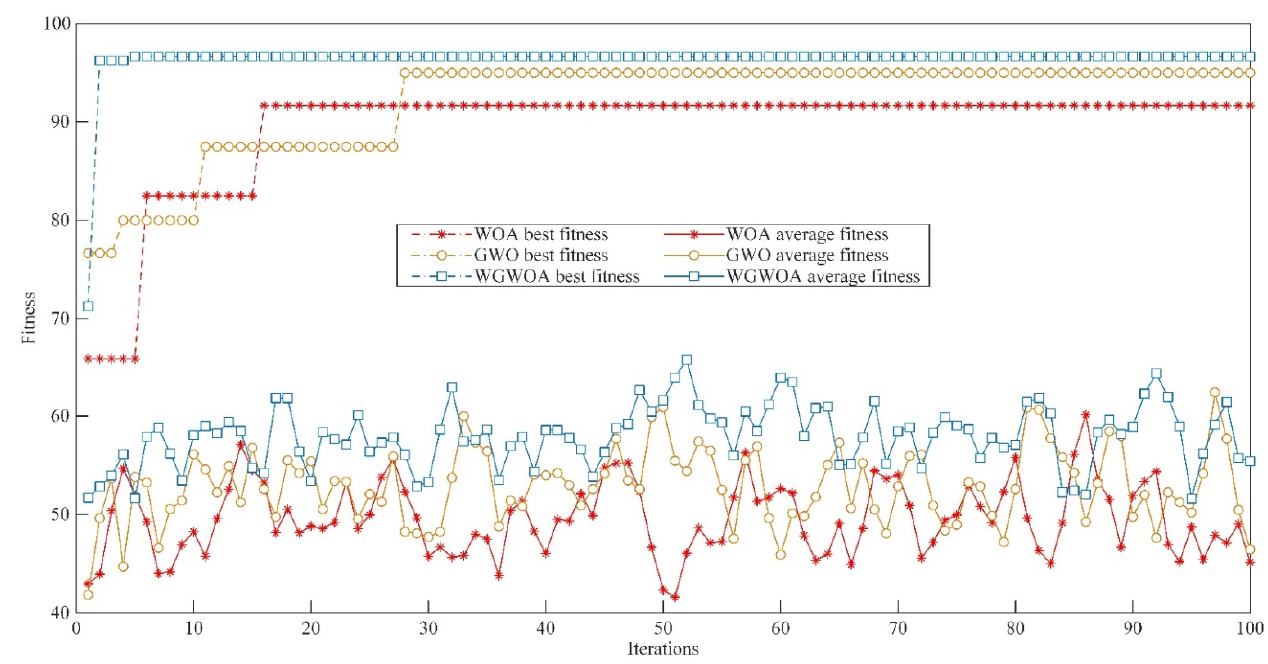
Figure 18. Different algorithms used to optimize the fitness curve of SVM. Table 9. Optimal solution of SVM parameters found by different algorithms.